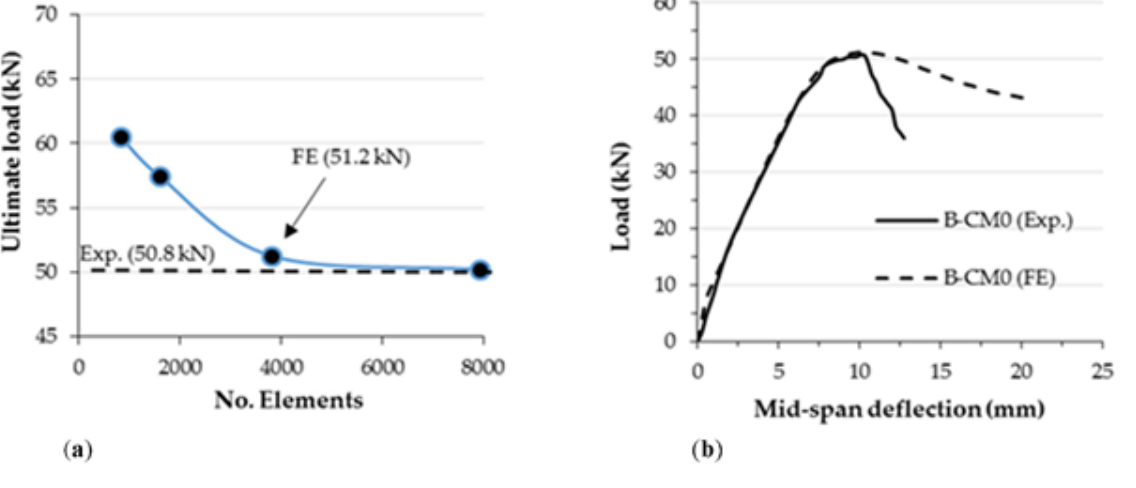
Figure 18. Verifying the results of FE model B-CM0: ( a ) Mesh size convergence study; ( b ) Compare the load-deflection curve.